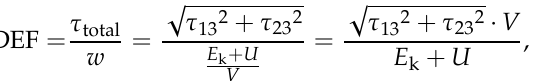
Figure 10. ( a ) Ice/substrate interface shear stress nephogram for four different icing cases; ( b ) The total shear stress for delamination and deicing efficiency factor for the four icing cases.